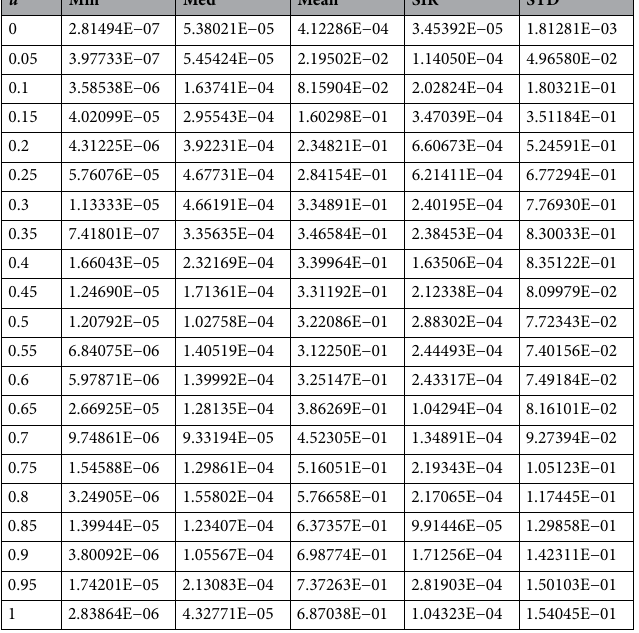
Table 3. Statistical presentations via stochastic performances for solving the novel SO-PSDDM-based Problem 3.